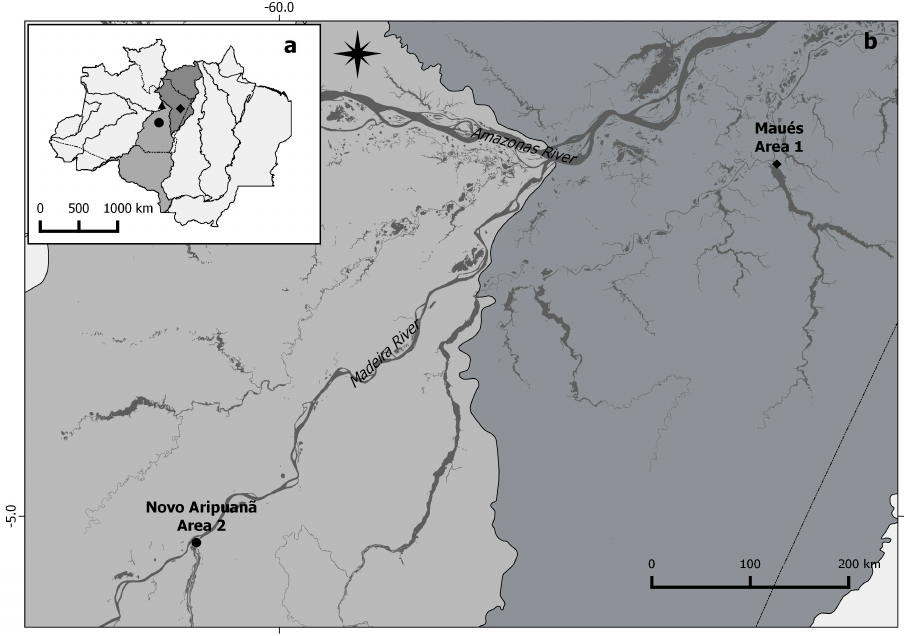
Figure 1. Map of study areas showing ( a ) Brazilian Legal Amazon, and Amazon River sub-basins; and ( b ) Maués, directly linked to main Amazon River channel and Novo Aripuanã just inside Madeira River basin.